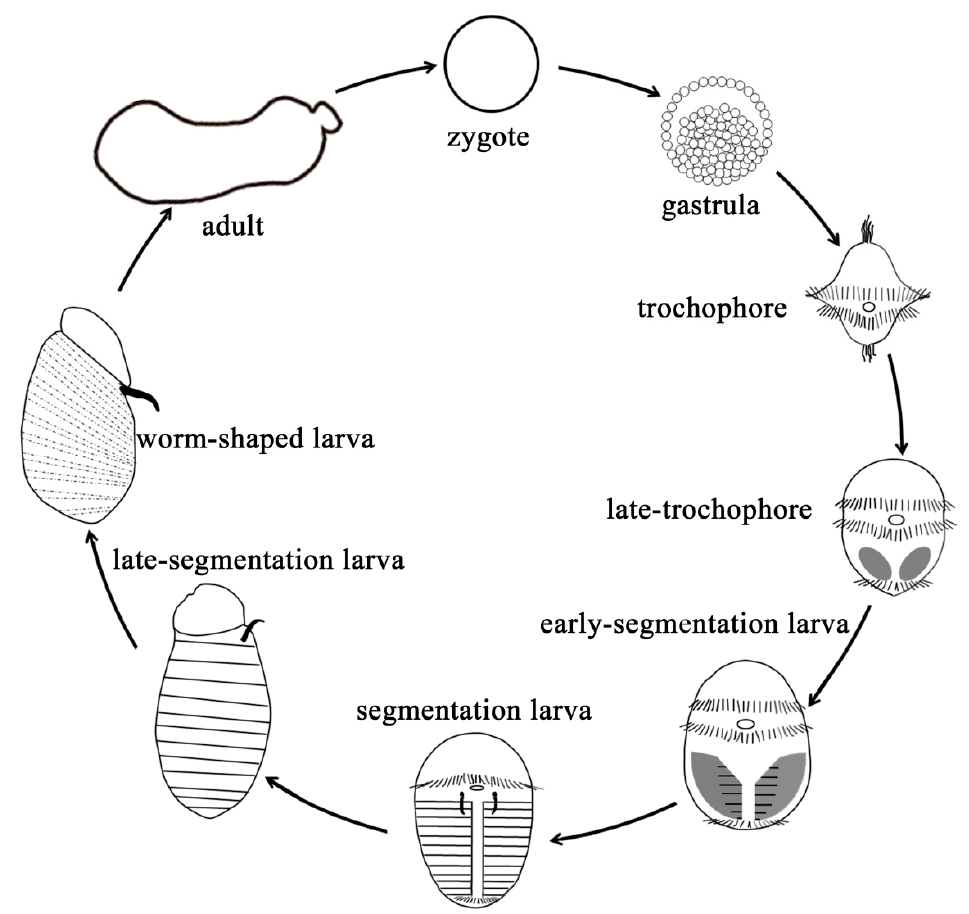
Figure 1. The life cycle of Urechis unicinctus . The gastrula hatches and develops into a swimming larva, the trochophore, in which a prototroch separates the larva into the episphere (upper hemisphere) and the hyposphere (lower hemisphere) to form the head and the trunk, respectively. The segments occur firstly in the early-segmentation larva and then maintain through the late-segmentation larva. The secondary loss of the segments appears in the worm-shaped larva whose inhabit mode changes from free-living into burrowing in the sediment. A body plan without segments is kept in adult U. unicinctus .